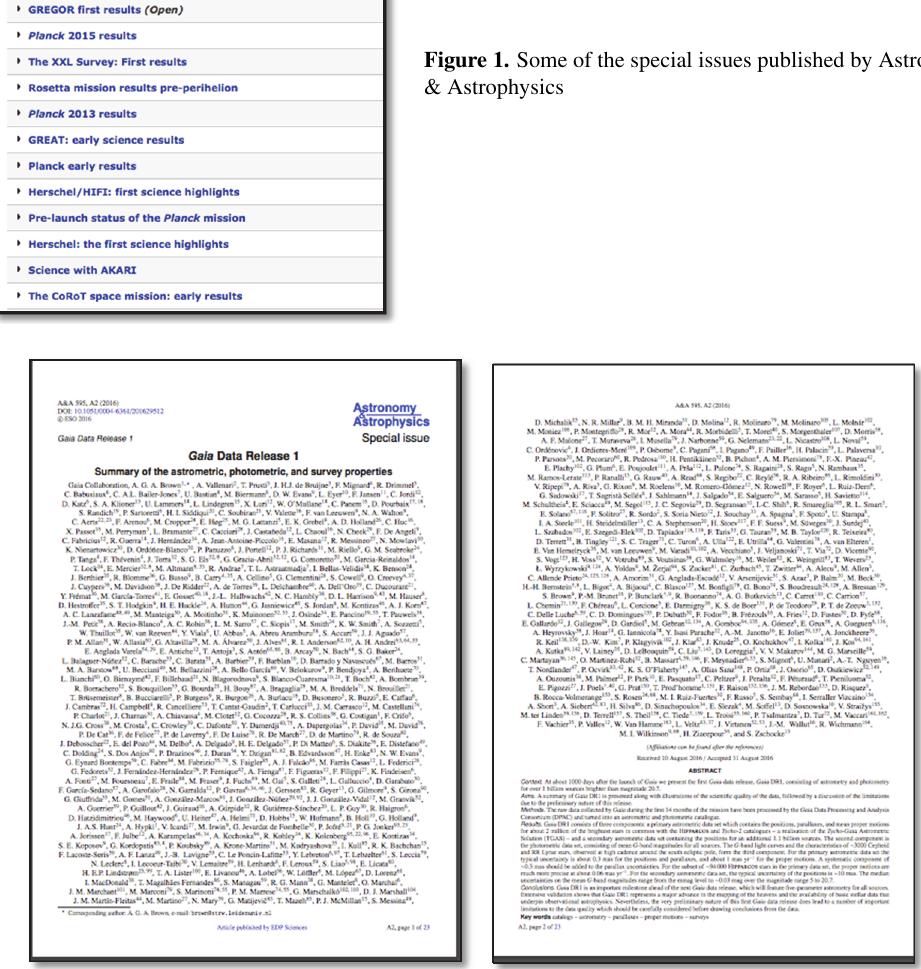
Figure 2. The many contributors to the Gaia Data Release